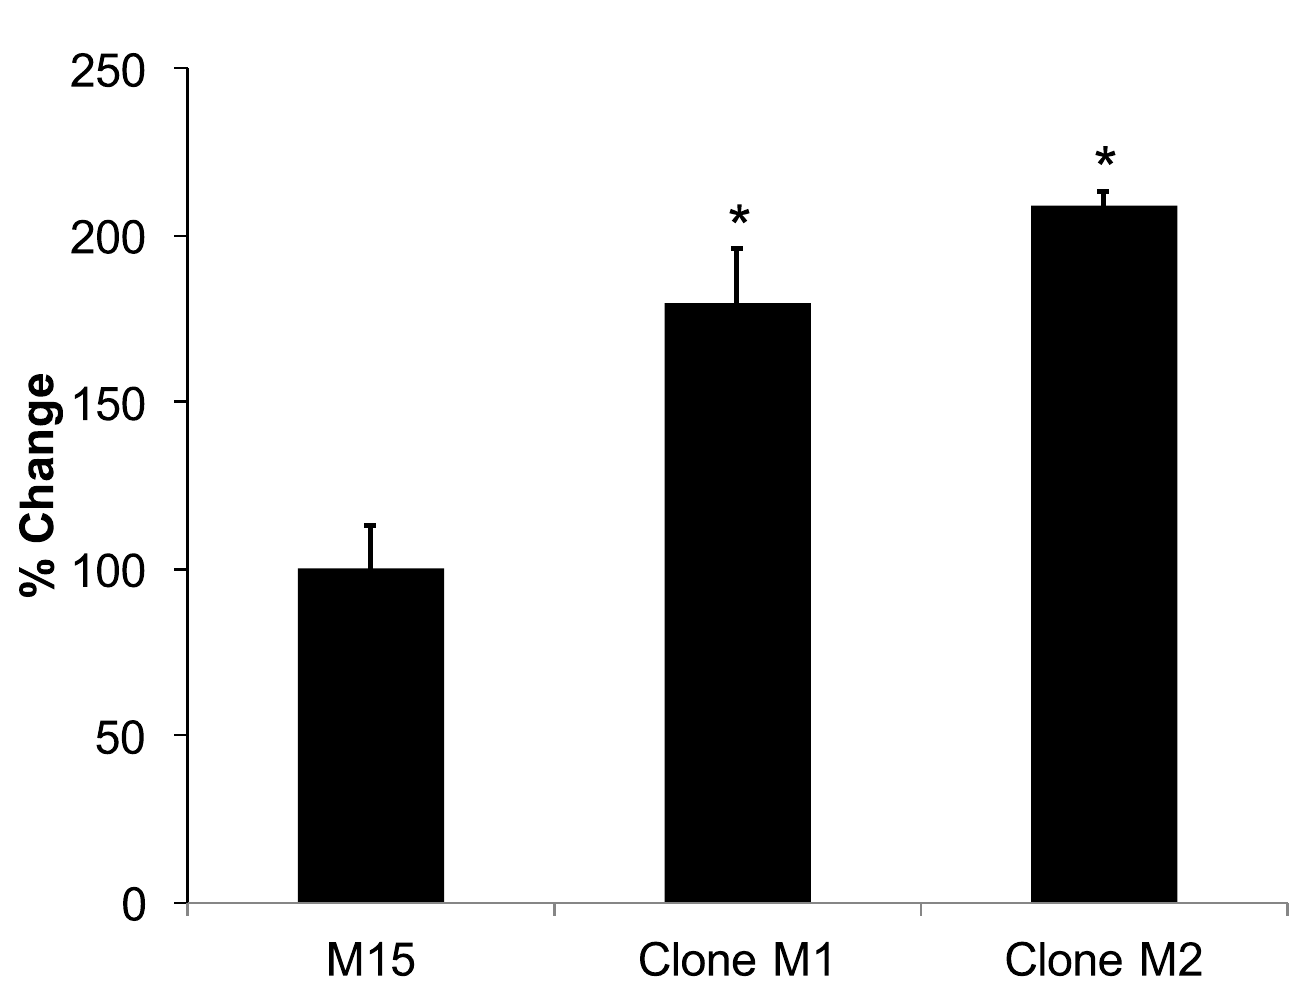
Fig 3. Loss of STAT6 increases growth proliferation rate of clones of M15 cells. � Indicates statistical significance relative to the respective parental cells. Results are the means ± SEM of three independent experiments (n = 3). % Change refers to the change in proliferation relative to the parental